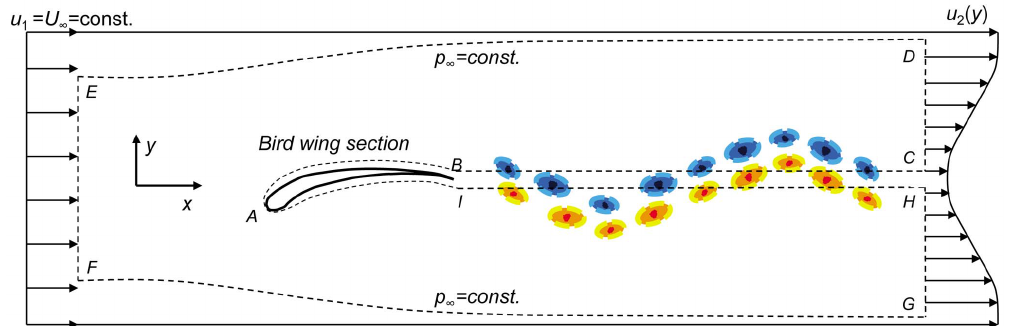
Figure 10. Control volume around a two-dimensional bird wing section in a uniform free stream.